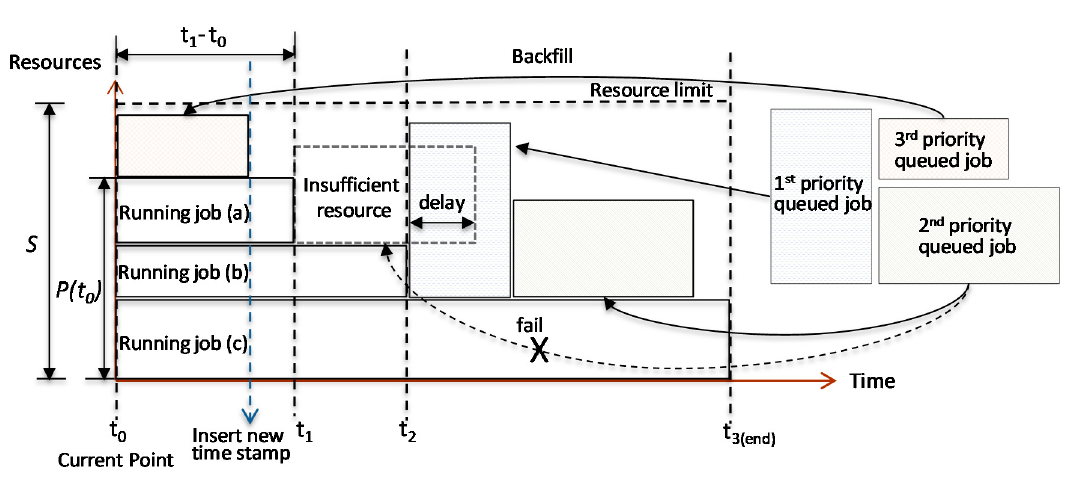
Figure 5. Conservative backfilling. Algorithm 1: Conservative backfilling